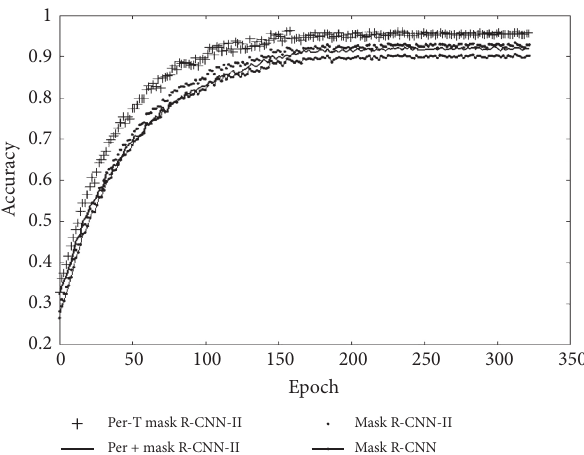
Figure 6: Schematic diagram of the four network